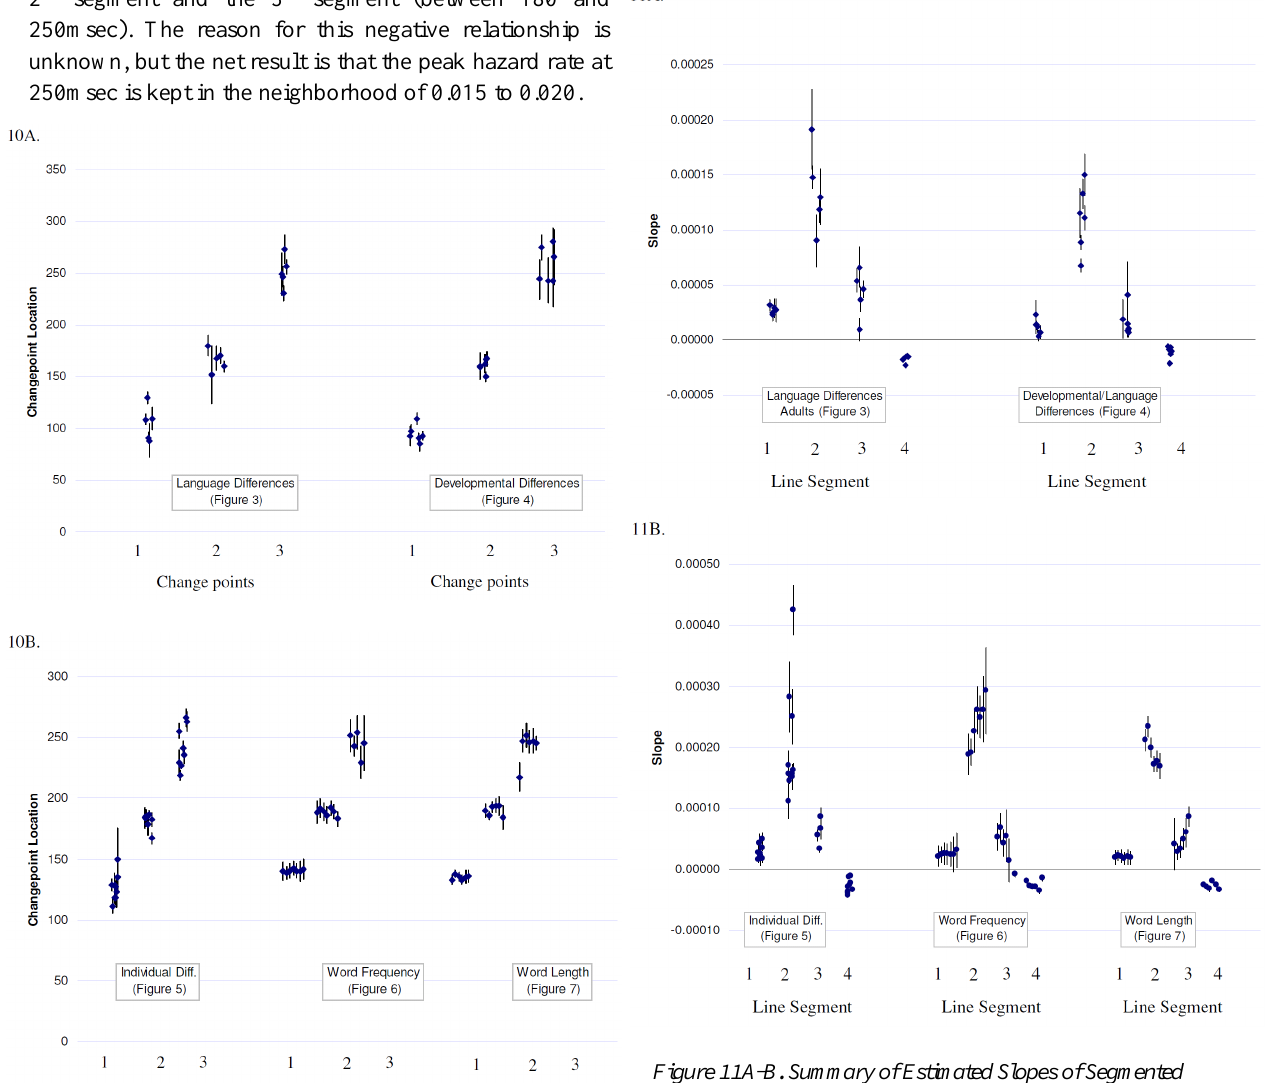
Figure 11A-B. Summary of Estimated Slopes of Segmented Linear Regression. Data in Panel A are from independent corpora. Data in Panel B are from the Dundee corpus Not all slopes are subject to systematic influences, though. The slope between 0 to 100msec is low but consistent across datasets, so are the negative slopes of the declining phase after 250msec. These stable slopes, along with the consistent timing of the changepoints, strongly constrain the overall shape of the hazard function of reading fixation